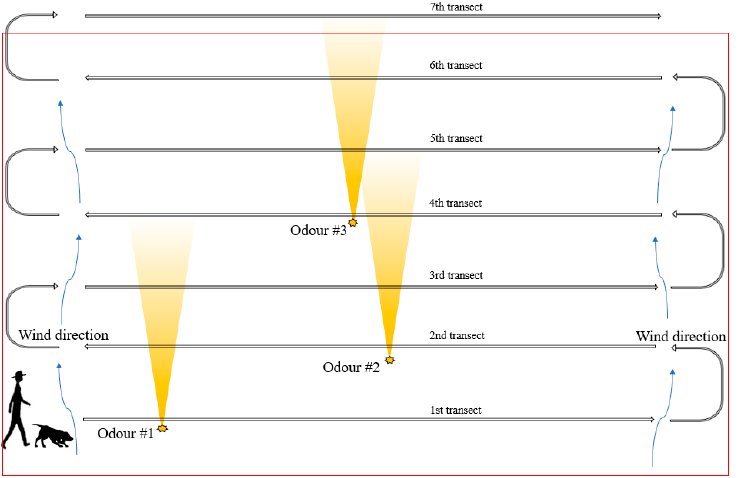
Figure 3. Third stage of transect search training designed to help increase search effectiveness and area coverage. Here teams begin upwind from the target odor and complete parallel search transects, enabling dogs to sample a new ‘corridor’ (area between transect lines) of odors with each new transect.